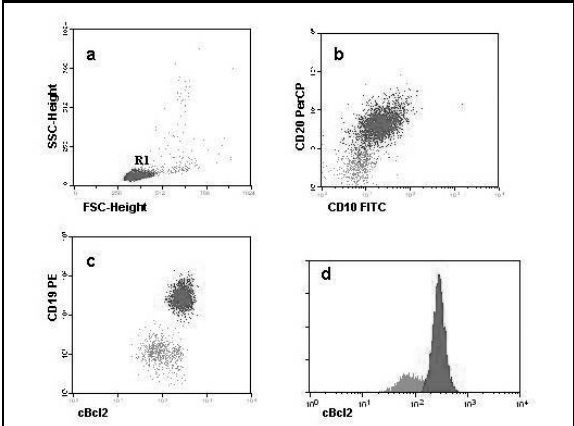
Figura 1 – Representação gráfica da análise em citometria de fluxo de um caso de linfoma folicular. a) Distribuição em dot plot das células selecionadas na região